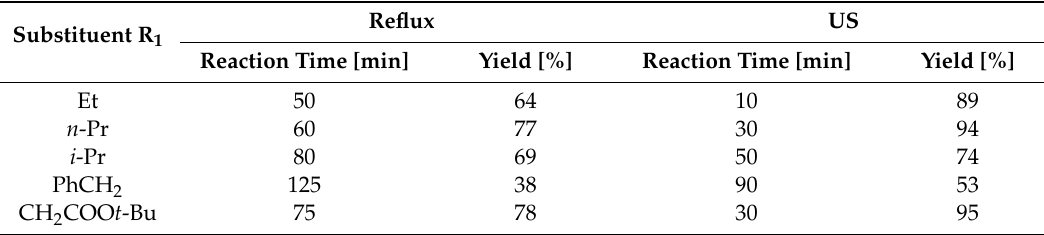
Table 3. Comparison between the results for reaction of 1a with organomagnesium reagents under thermal and ultrasonic initiation.